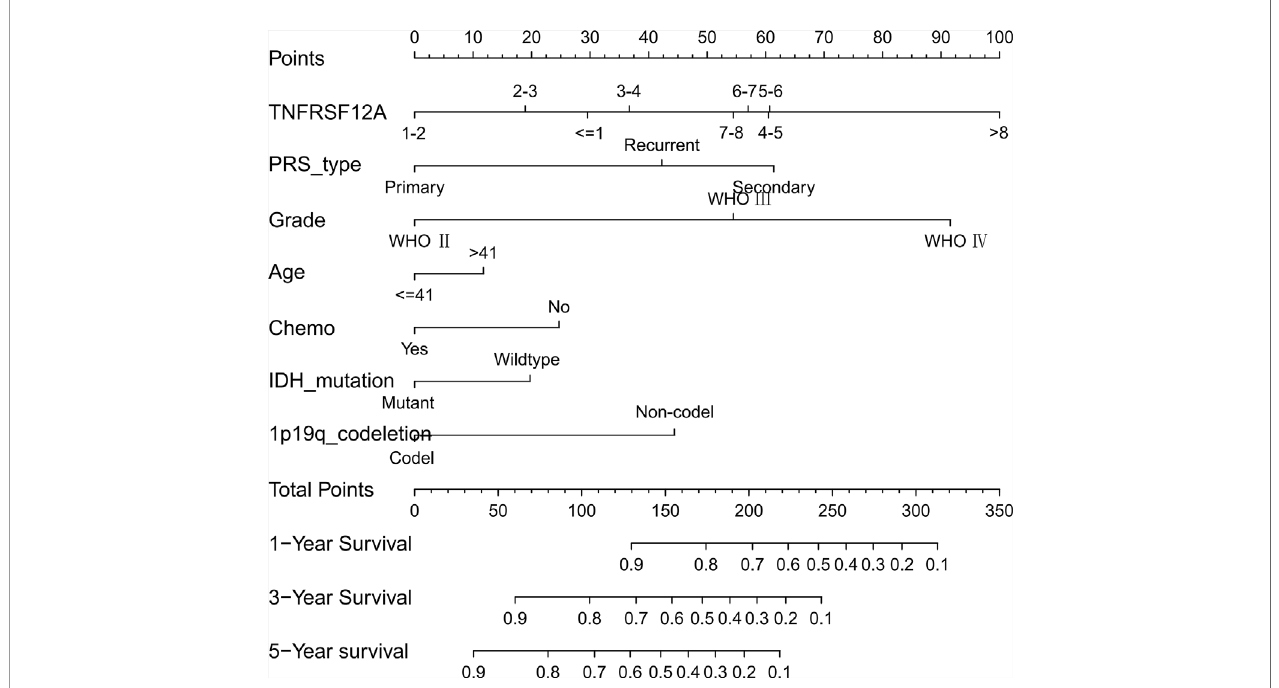
FIGURE 5 | Nomogram of 1-year, 3-year, and 5-year survival in glioma patients with CGGA.